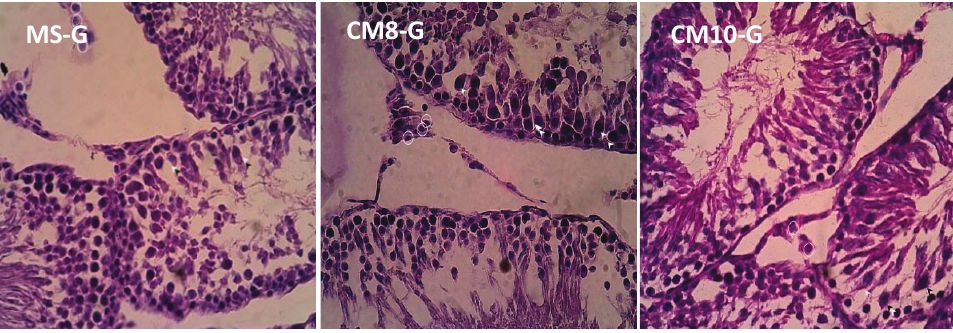
Figure 1. Leydig and Sertoli cells on Hematoxylin Eosin stain method identified by light microscope with 400x magnification in three groups. Post Hoc analysis: * p < 0.05